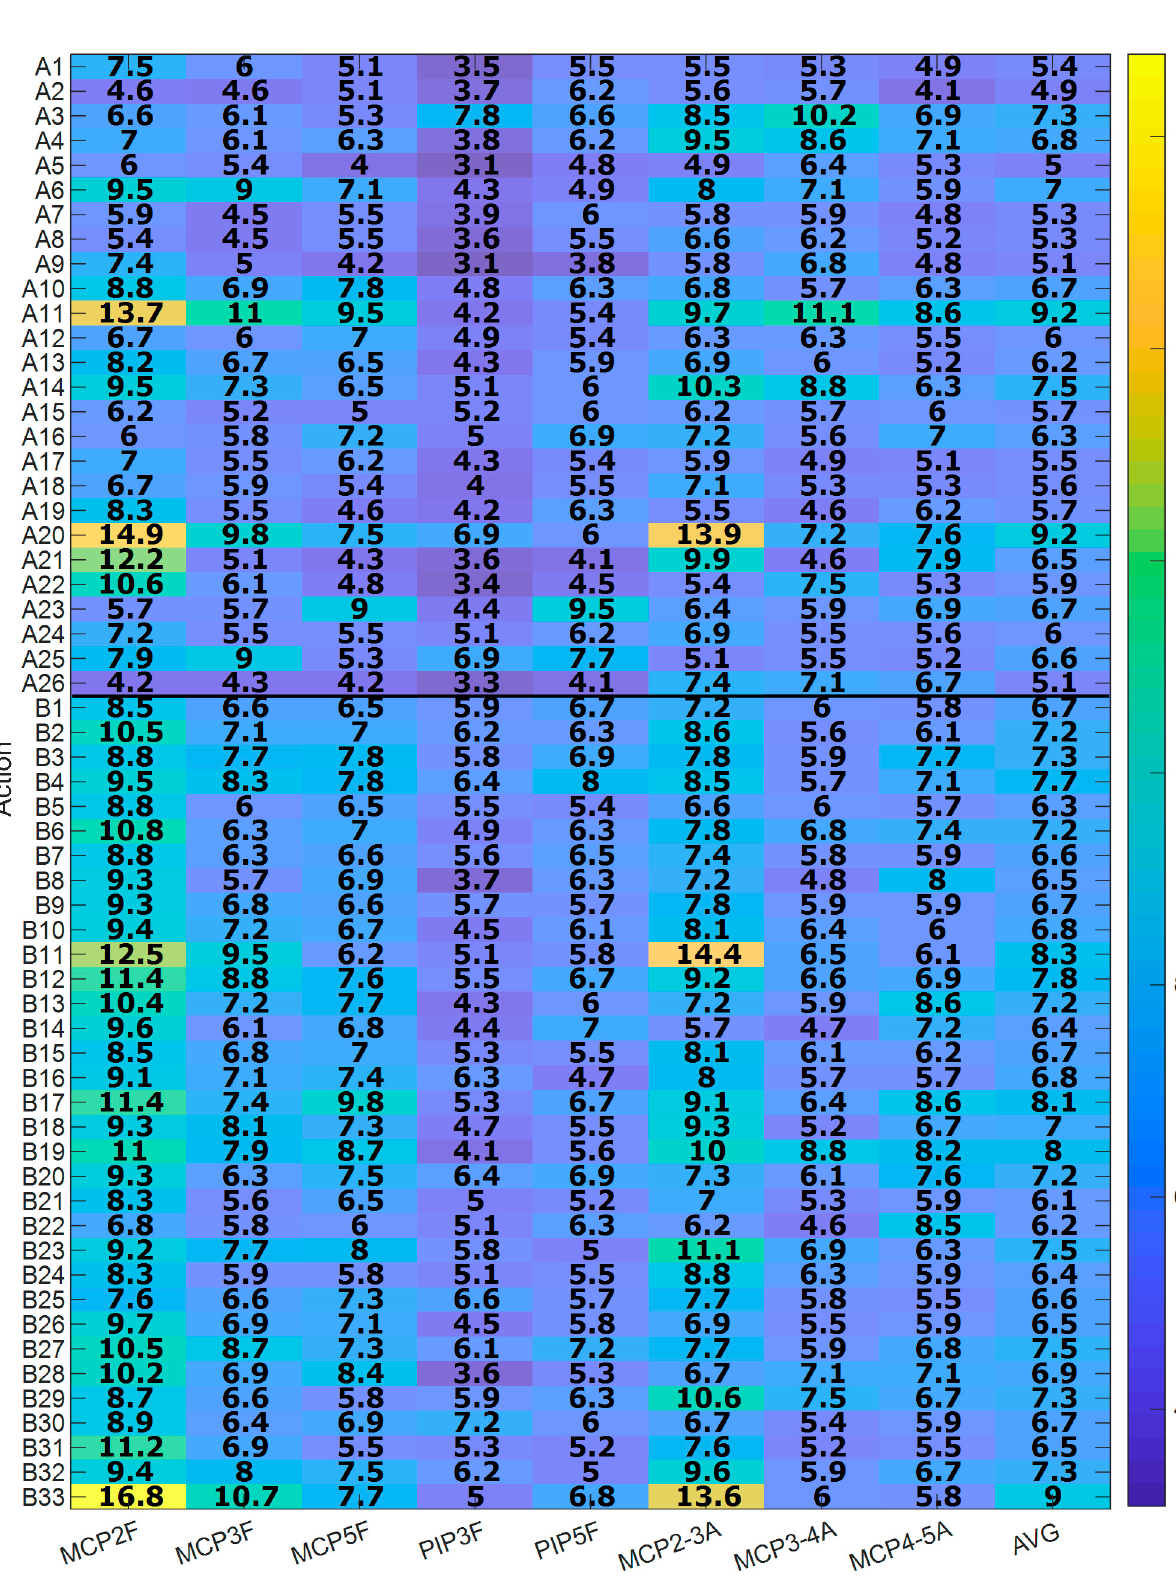
Figure 8. RMSE per joint and action (Experiment B), expressed as a percentage with respect to the RoM of each DoF. The last column represents the average between DoF (AVG). 1 to 5 refers to thumb to little fingers. F stands for flexion/extension and A for abduction/adduction movements.